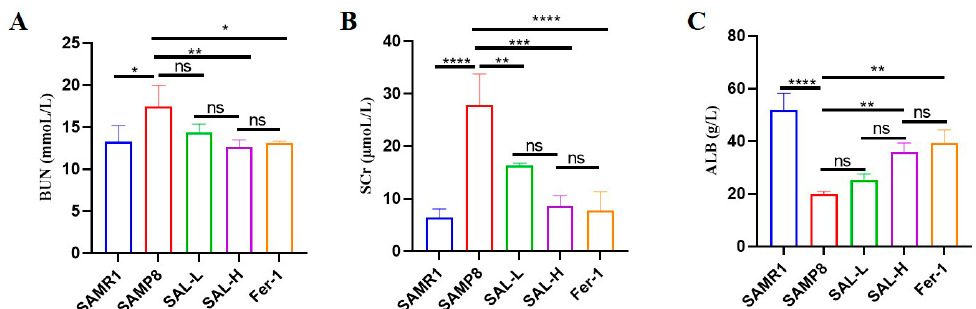
Figure 4. Effects of SAL on renal function parameters in the serum of SAMP8 mice. ( A ) The blood urea nitrogen (BUN) serum level. ( B ) The serum creatinine (SCr) level. ( C ) The albumin (ALB) serum level. Data are expressed as means ± SD, * p < 0.05, ** p < 0.01, *** p < 0.001, **** p < 0.0001.